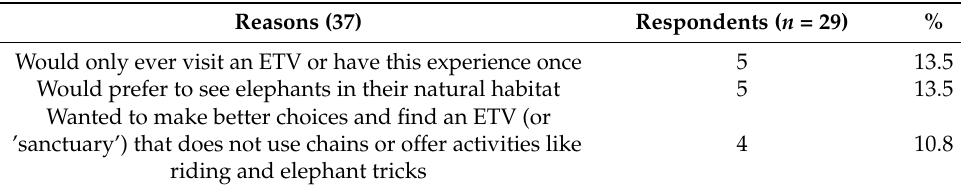
Table 4. Top three reasons respondents gave for not returning to the ETV they